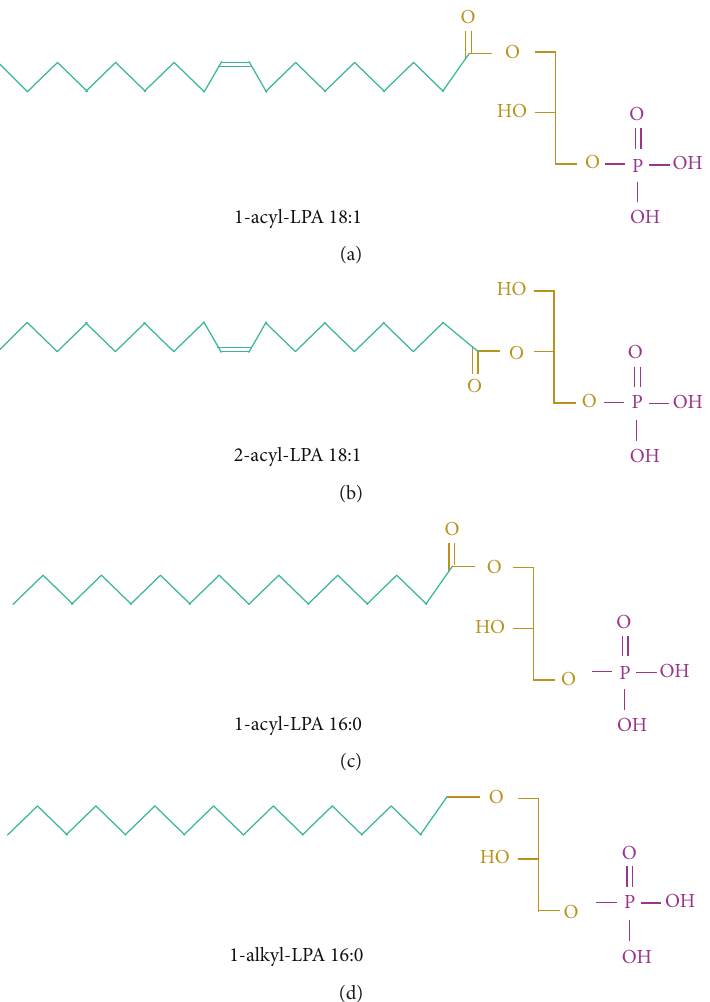
Figure 2: LPA species. LPA is derived from phospholipids with di ff erent lengths and saturations. (a) 18 carbon LPA species with an acyl group in sn-1 position and one saturation are the most potent activator of the LPA with 18 carbons, one saturation, and the fatty acid chain in sn-2 position are the most potent activator of LPA (c) An alkyl-LPA species with 16 carbons and no saturation are the most potent activator of LPA